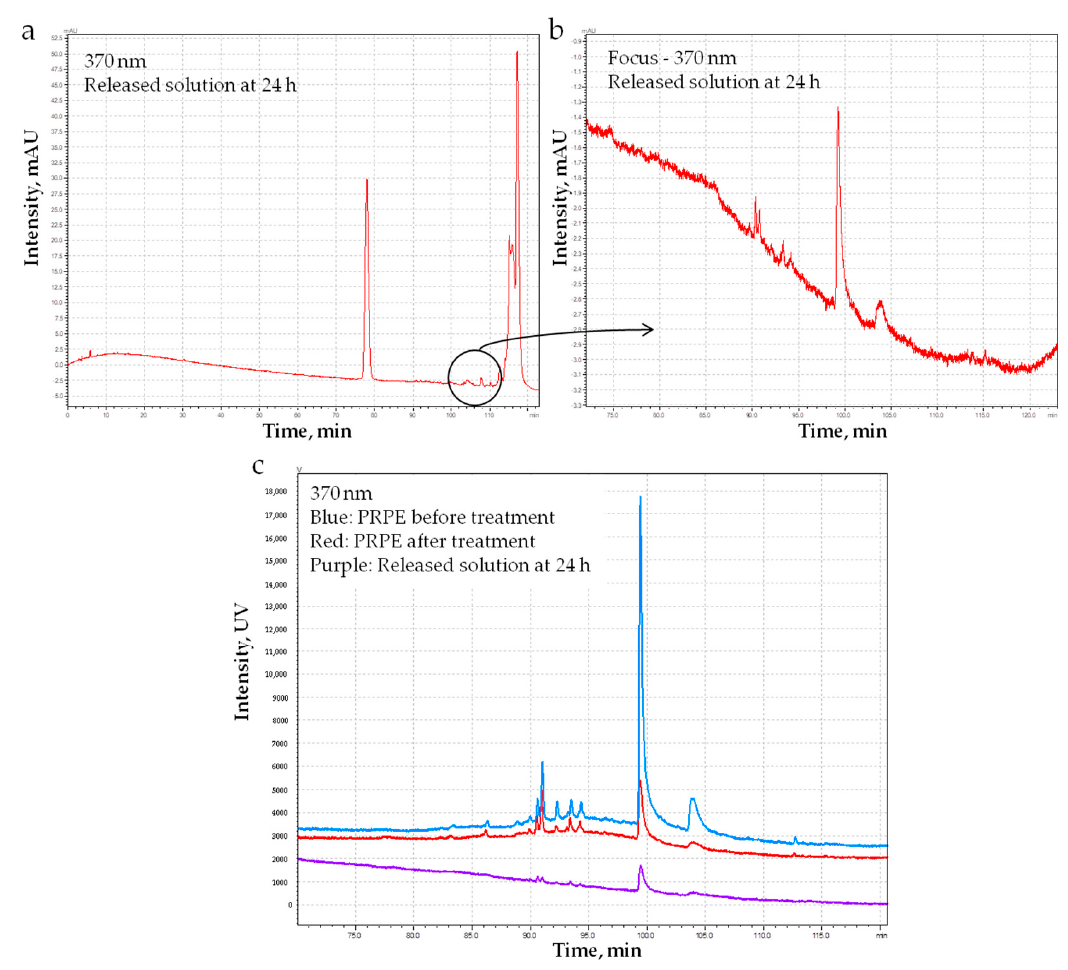
Figure 9. ( a ) HPLC analysis of the released solution after 24 h at 370 nm and ( b ) focus on the peak of quercetin. ( c ) Comparison among the chromatograms of the PRPE before and after the treatment of the pericardium membrane and the chromatogram of the released solution at 24 h.